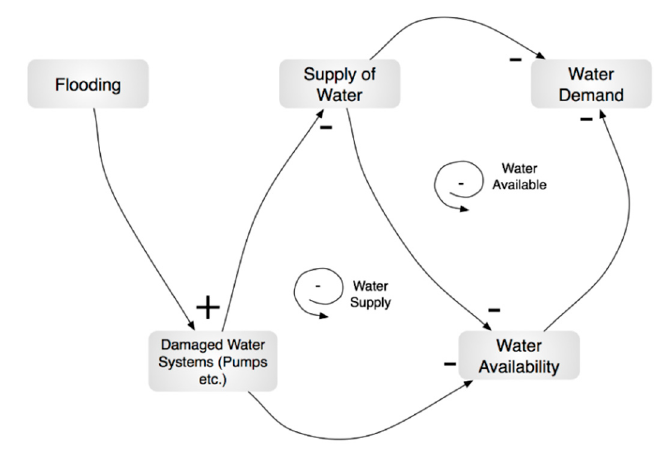
Figure 7. Causal loop of water problem .